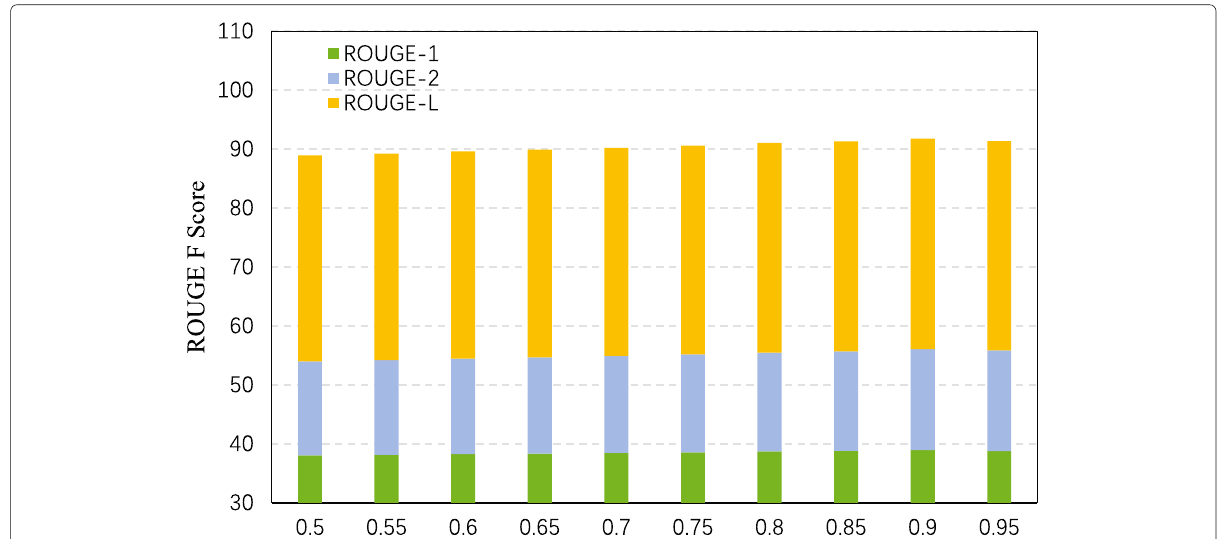
Fig. 3 The performance of our model. ROUGE-1, ROUGE-2, and ROUGE-L F1 scores of KIGN+prediction-guide model w.r.t different hyperparameter α